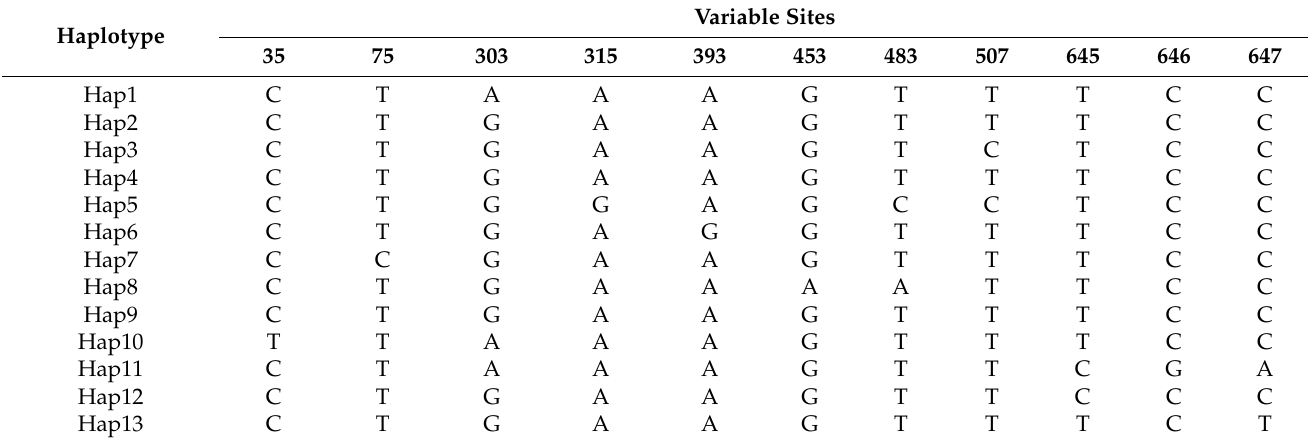
Table A1. Variable sites of mitochondrial DNA COI gene haplotypes in N. taihuensis.